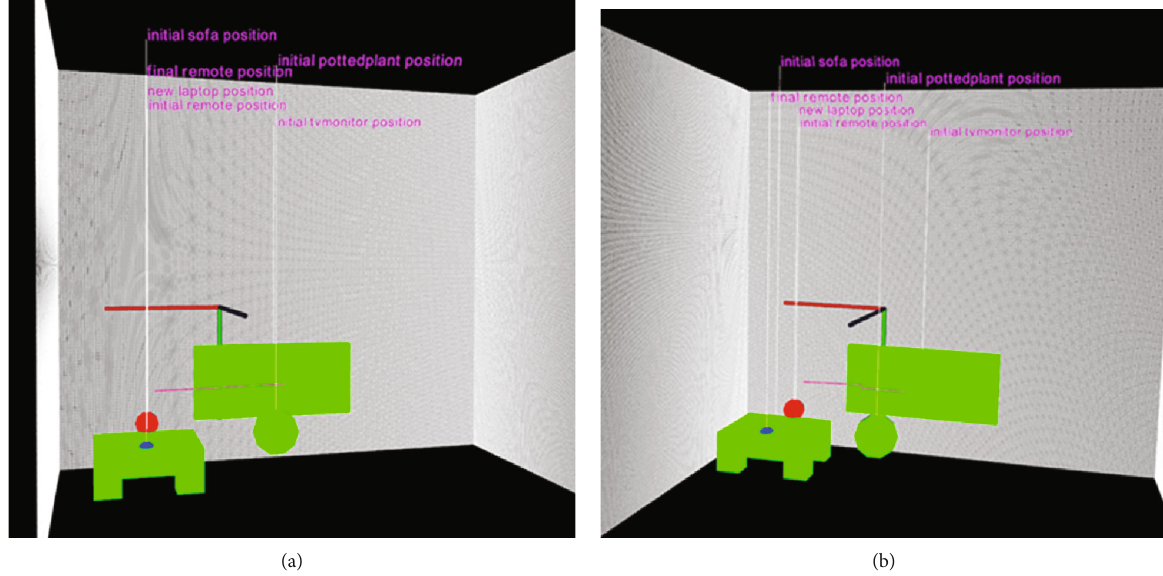
Figure 9: A simpli fi ed example of virtual scene summary based on the actual segmented point cloud of Figure 8. This simpli fi ed version can further be populated with the actual CAD model of the object for better